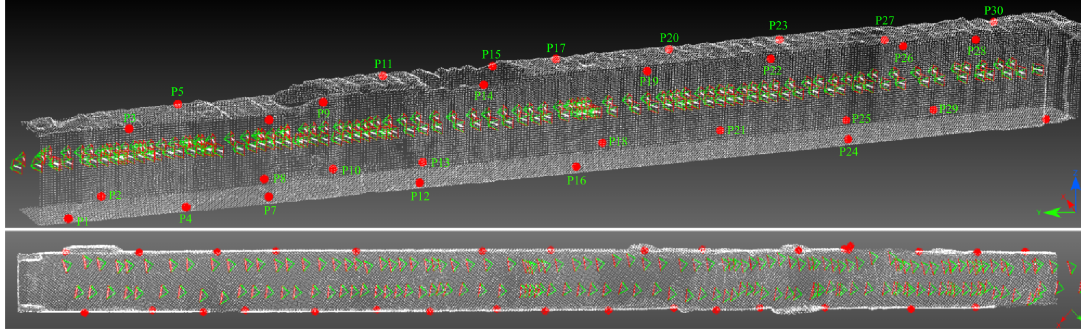
Figure 19. The Hallway dataset acquisition with GCP points